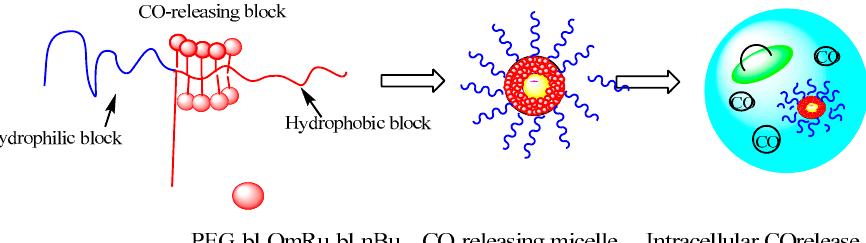
Figure 6. Triblock copolymer assembles for releasing the CO at biological sites.